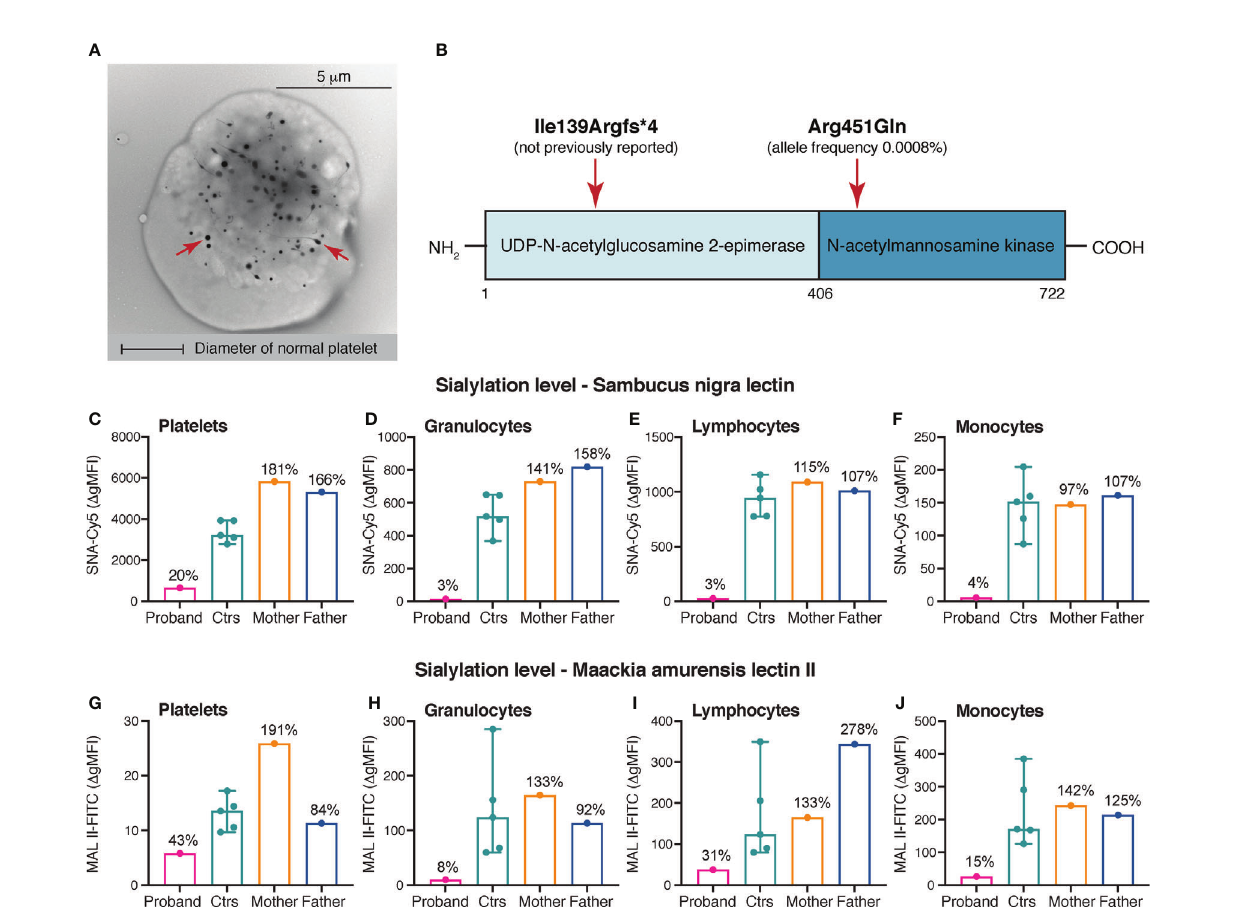
FIGURE 1 | Platelet electron microscopy, variants identi fi ed in GNE and sialylation levels on platelets and leukocytes. (A) Whole mount transmission electron microscopy image of a giant platelet (> 8 m m in diameter) of the proband. Original magni fi cation x7.900. For comparison the diameter of a normal platelets is depicted. The red arrows mark dense granules. (B) Linear domain organization of UDP- N -acetyl-glucosamine-2-epimerase/ N -acetylmannosamine kinase encoded by GNE. The approximate positions of the variants identi fi ed in the proband are shown. (C – J) Sialylation of platelets, granulocytes, lymphocytes and monocytes. a - 2,6- and a -2,3-linked sialic acid was detected by fl ow cytometry using Cy5-labeled SNA (250 ng/mL) and FITC-labeled MAL II (100 m g/mL), respectively. A markedly decreased sialylation of all cell types was demonstrated in the proband compared with healthy controls. The heterozygous parents of the proband did not show reduced levels of sialic acid on the investigated cell types. The results of the healthy controls ( n = 5) are shown as medians with min-max. The results in the proband and the parents are presented as percentages of the median D gMFI in the control group. SNA, Sambucus nigra lectin; MAL II, Maackia amurensis lectin II; gMFI, geometric mean fl uorescence